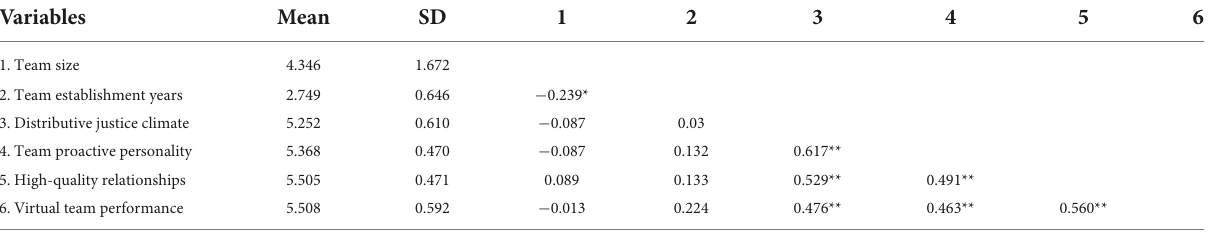
TABLE 3 Means, standard deviations, and correlation coefficients between variables.